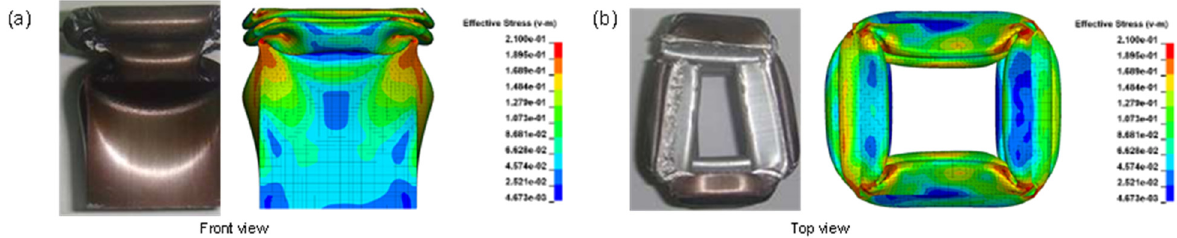
Figure 3: Comparison results between experiment and fi nite element of the tube under axial loading: ( a ) front view and ( b ) top view.